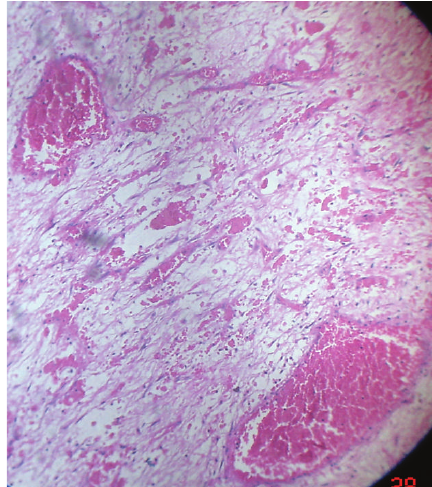
Figure 4: Photomicrograph showing the presence of large cav- ernous spaces lined by endothelial cells [ 10